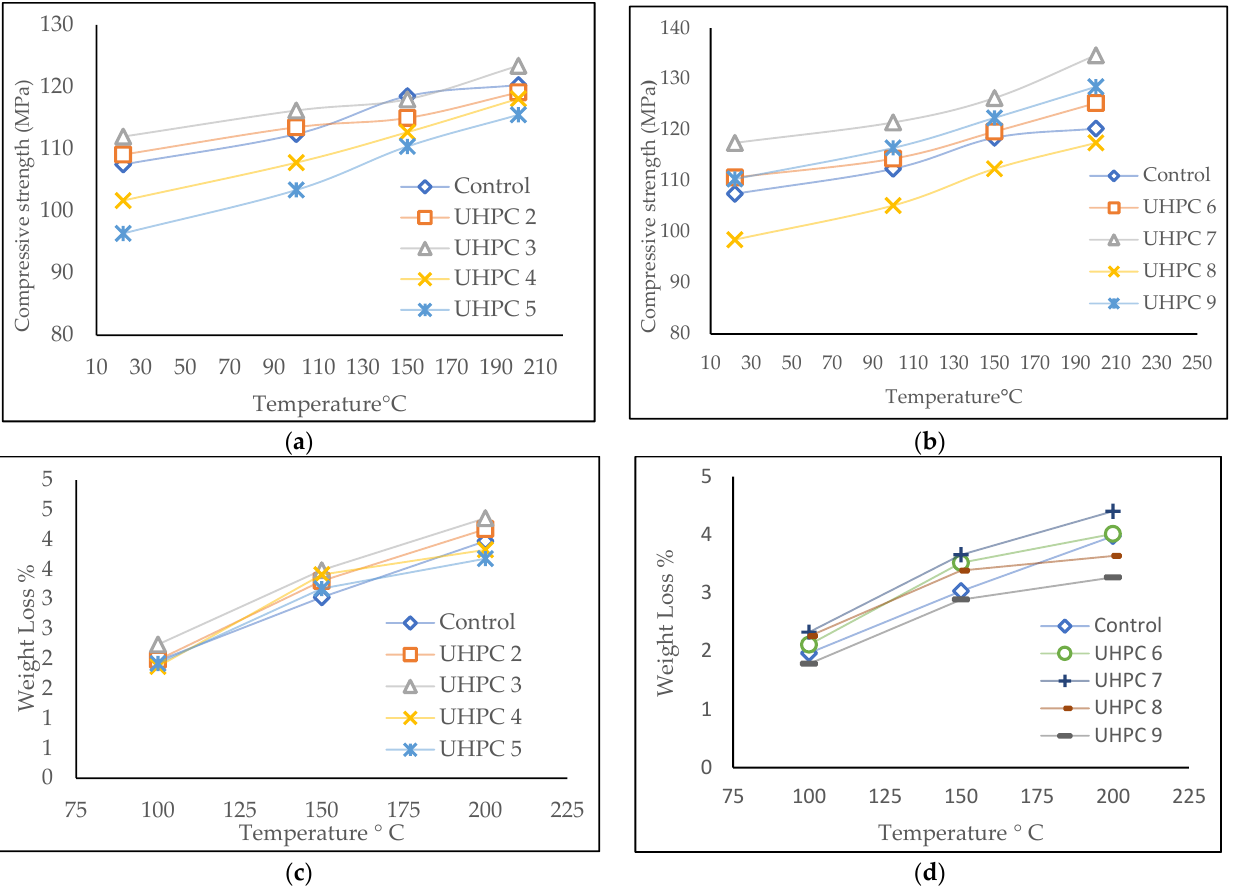
Figure 11. Compressive strengths and weight loss ratios under different temperatures of UHPC. ( a , c ) glass powder and ( b , d ) lime powder.